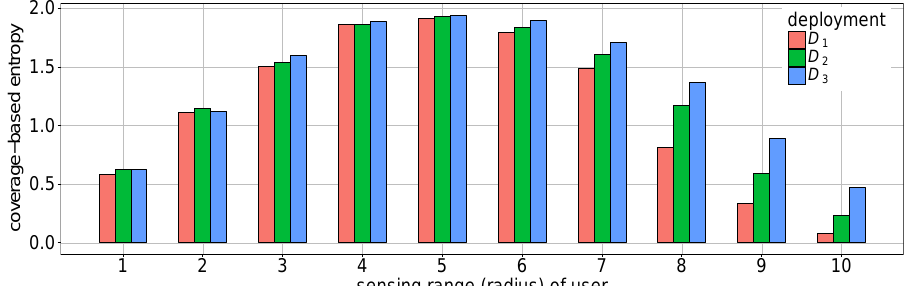
Figure 4. Coverage-based entropies of a random event under the three deployments shown in Figure